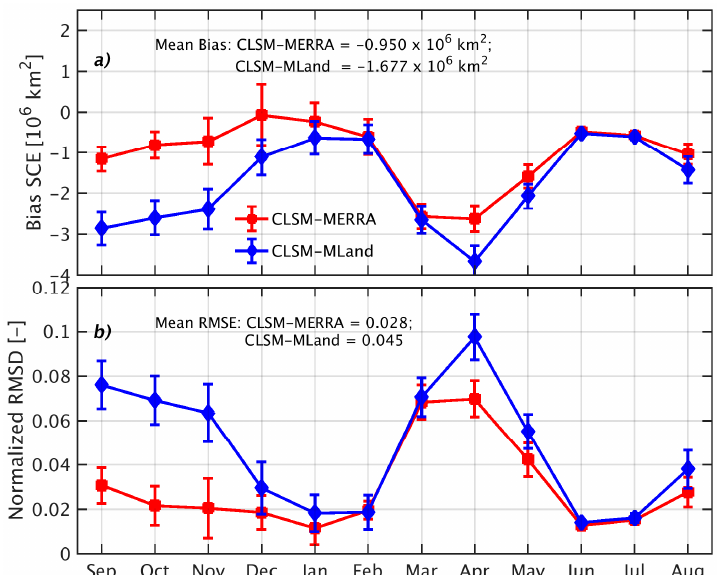
Figure 1. ( a ) Bias and ( b ) normalized RMSD of monthly SCE from CLSM-MERRA and CLSM-MLand for part of the Northern Hemisphere poleward of 35 o N for the period 1 September 2001 to 1 September 2009. Metrics are computed vs. monthly MODIS SCE observations. Error bars represent the standard deviation across space. Normalization of the RMSD in ( b ) is by the maximum annual MODIS SCE.